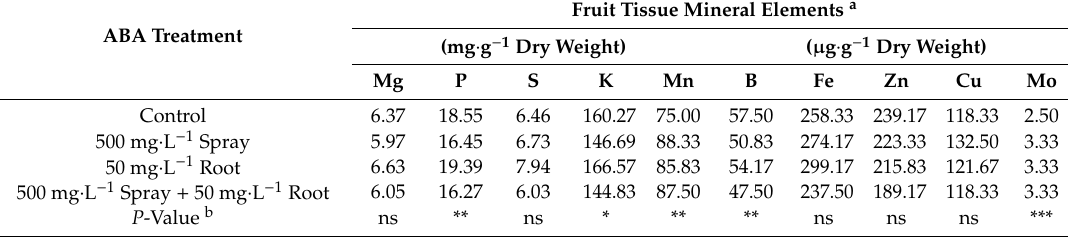
Table 2. Mineral nutrients in fruit tissue of ‘Mt. Fresh Plus’ tomato plants grown in a greenhouse and treated with exogenous applications of abscisic acid (ABA). Fruit tissue was harvested at 84 d after seeding from the second cluster at the red ripe stage for each treatment and replication for mineral nutrient analysis.